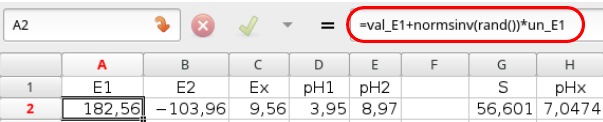
Figure 4. A table in Gnumeric containing the uncertain input data.